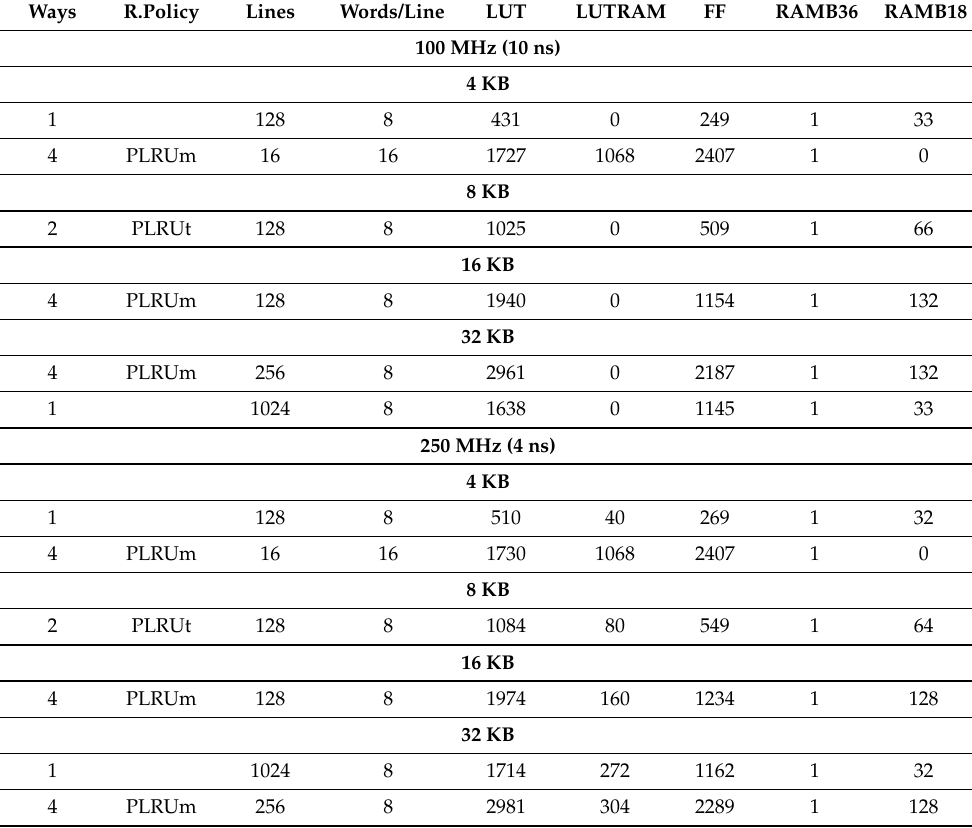
Table 5. IOb-Cache (Native) resource and timing